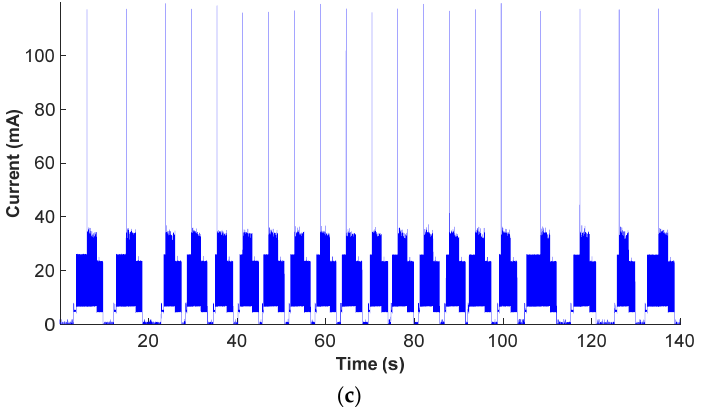
Figure 12. Current consumed by the SmartConnector . ( a ) Measured with the CX3324A current waveform analyzer during one entire BLE communication cycle. ( b ) Measured with the CX3324A current waveform analyzer during the sleep mode. ( c ) Measured with the lab-design system during 20 BLE communication and sleep cycles.